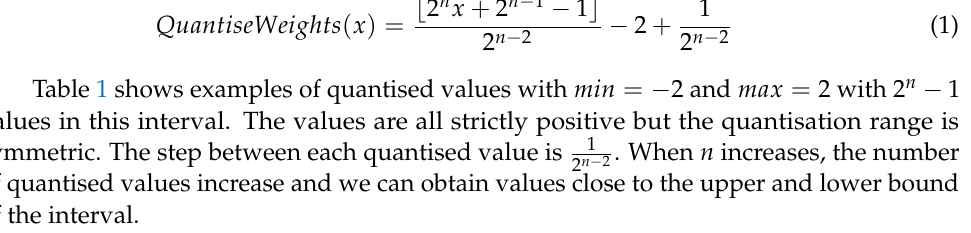
Table 1. Quantised weight values between 0.136 and 2 with min =